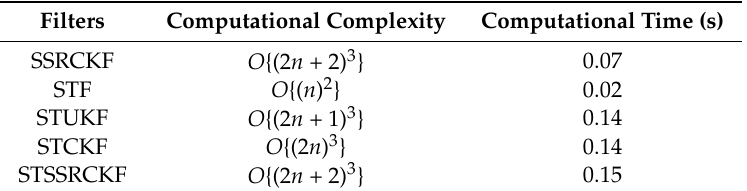
Table 2. Computational complexity and computational time of different filters.